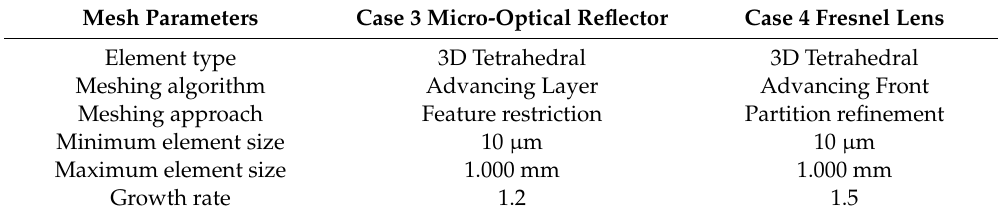
Figure 14. The multi-scale mesh of the Fresnel lens with partial surface mesh refinement at ( a ) part level, ( b ) structured area level, and ( c ) at single micro feature level. Table 4. Multi-scale meshing parameters for the micro-structured plastic parts.